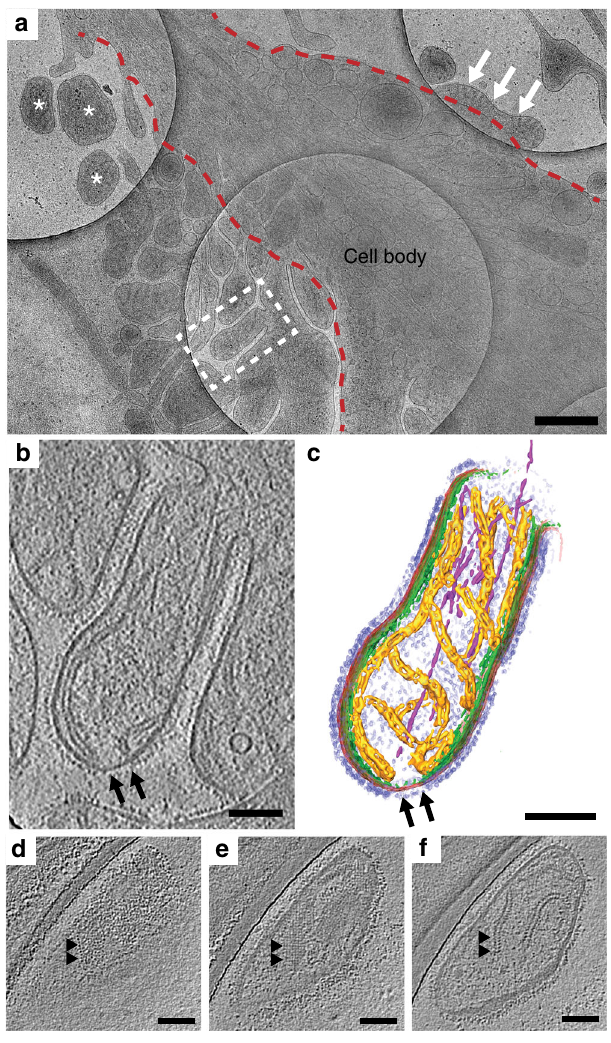
Fig. 1 Cryo-ET of MeV-infected HeLa cell. a An intermediate magni fi cation image montage of an Edm MeV-infected HeLa cell. Site of MeV assembly is indicated by dashed white box and is the location where the tilt series was acquired. Asterisks indicate released MeV particles, white arrows indicate MeV assembly site, and red dashed lines indicate the cell membrane. b Tomographic slice (1.18 nm thick) of Edm MeV assembly site. Black arrows indicate areas where M is absent on the viral membrane ( b , c ). c 3D segmentation view of the cryo-ET data ( b ). Glycoproteins (purple), viral membrane (red), M (green), RNP (gold), and actin fi laments (magenta) at the assembly site. d – f Sequential tomographic slices (1.18 nm thick) of a released virus particle (not shown in a ) showing glycoprotein layer ( d ), M layer ( e ) and RNP layer ( f ). Arrowheads indicate the same regions at different Z heights. Scale bars are 500 nm ( a ) and 100 nm ( b – f )